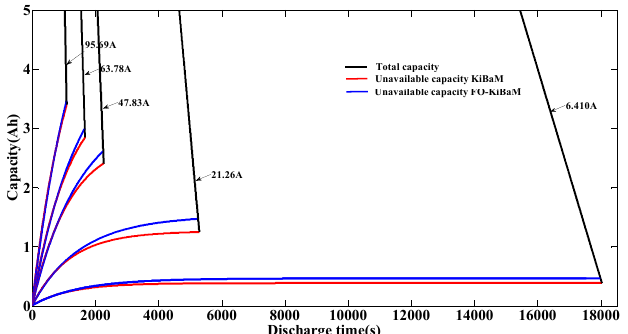
Figure 10. Battery capacity variance at different C-rates.